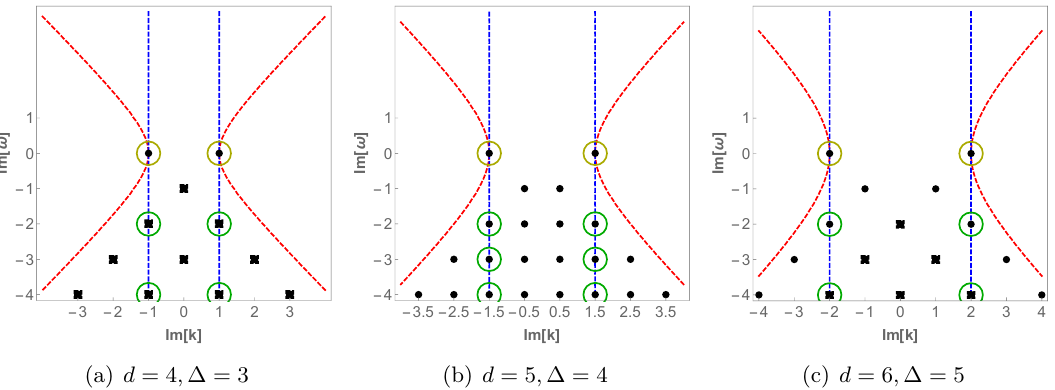
Figure 7 . The pole-skipping points of massless vector field (longitudinal channel) obtained from near horizon analysis. Black circles denote type-I while Black squares denote type-II points. Red dashed curves are lines of poles and blue curves are lines of zeroes coming from the